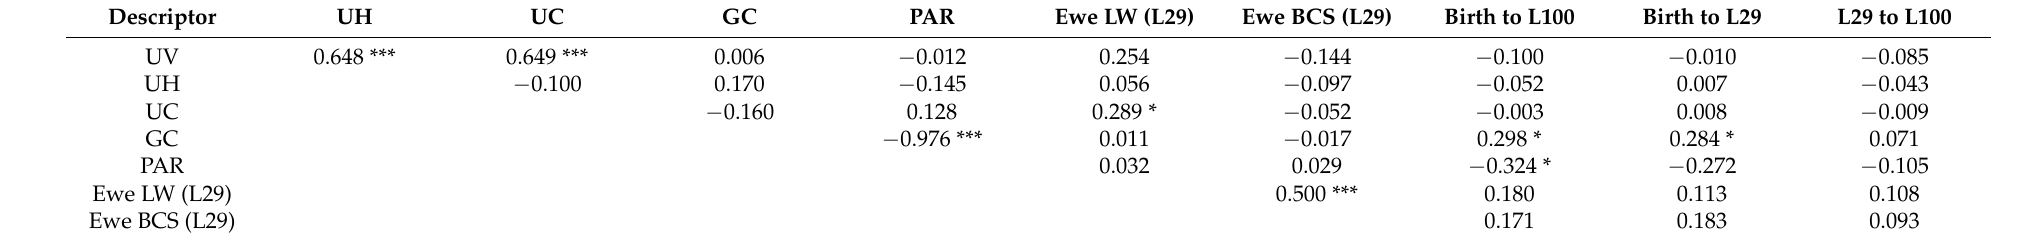
Table 5. Correlation coefficients of residuals of udder volume (UV), circumference (UC), height (UH), gland cistern (GC) and parenchyma (PAR) at L29, body condition score and live-weight of yearling ewes (Ewe BCS and Ewe LW) in early lactation (L29) 1 , lamb growth from birth to weaning (Birth to L100), birth to early lactation (Birth to L29) and early lactation to weaning (L29 to L100).